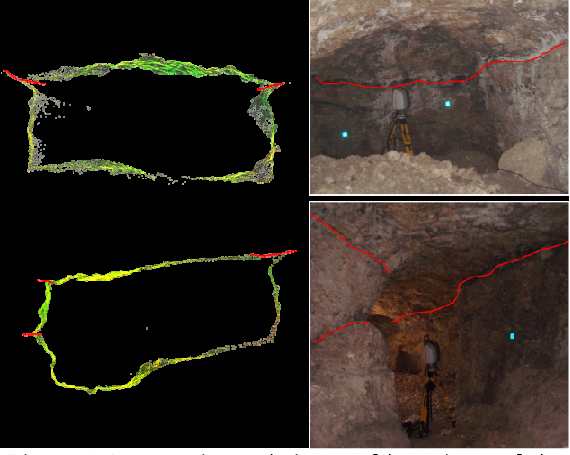
Figure 14. Cross sections and pictures of the main tunnel, the structural joints are highlighted in